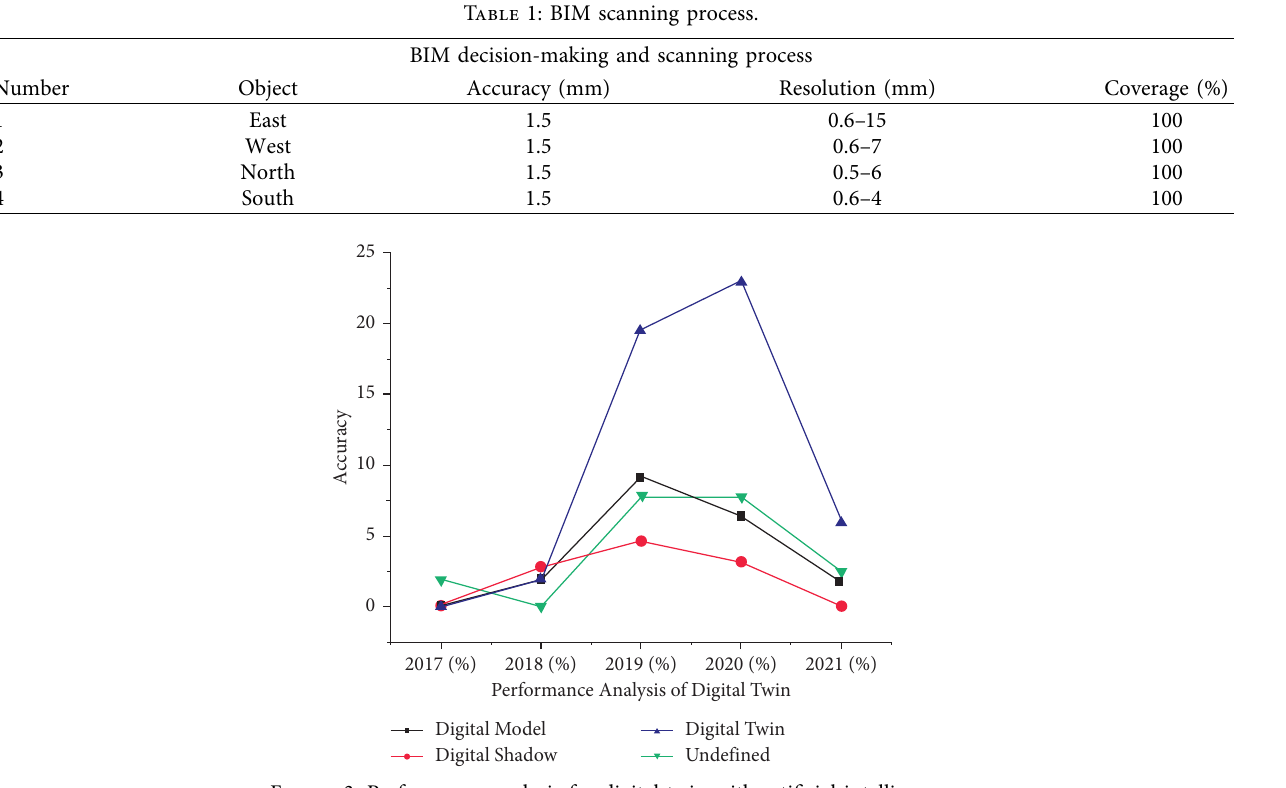
Figure 3: Performance analysis for digital twin with artificial intelligence. Table 2: Performance result analysis for digital twin with